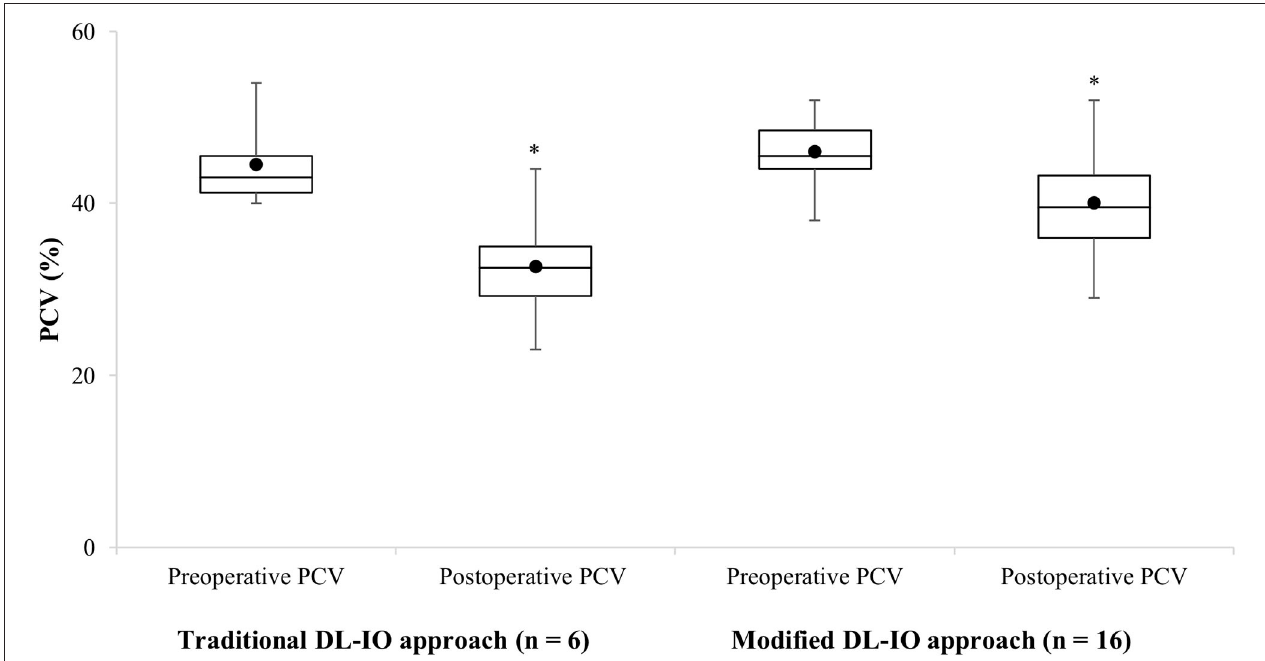
FIGURE 2 | Boxplot representation of the preoperative and postoperative changes in PCV in 22 dogs undergoing caudal maxillary via a combined approach (traditional DL-IO approach, n = 6, four animals received intraoperative packed red blood cell transfusions; modified DL-IO approach with preligation of the maxillary artery, n = 16, one animal received an intraoperative packed red blood cell transfusion). The horizontal line denotes the median, the boxes represent cases within the 25–75th percentile, and the upper and lower bars represent the highest and lowest observed values that are not outliers. Asterisk (*) denotes significant